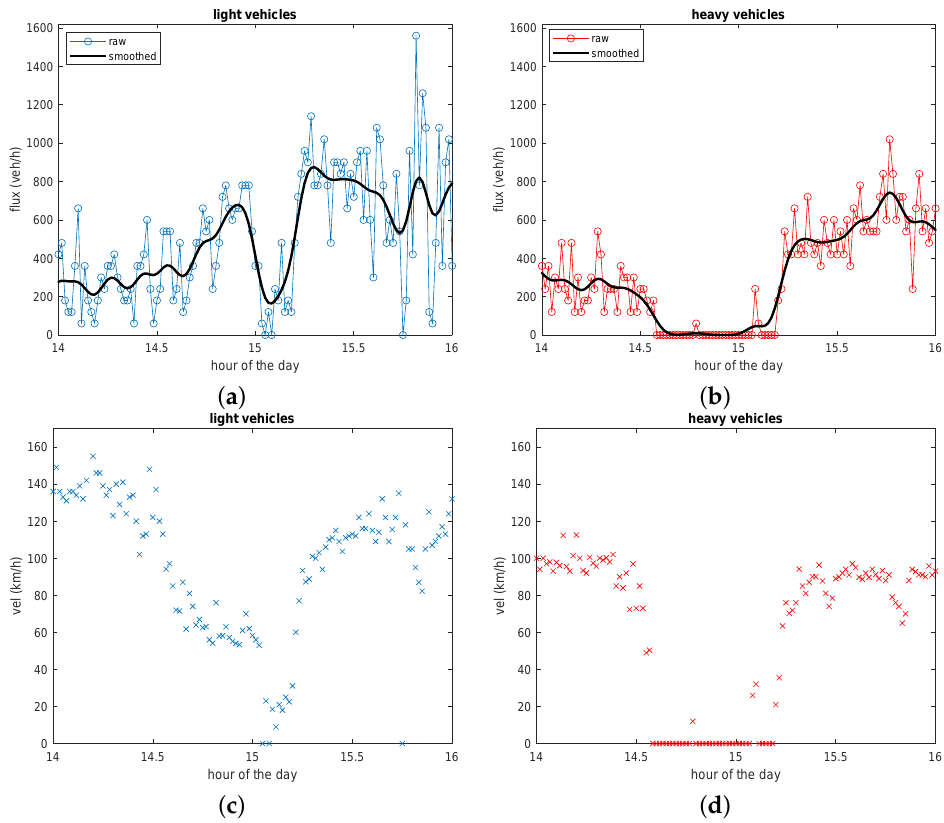
Figure 4. Creeping phenomenon registered in May 2019 near Portogruaro: ( a ) Light vehicles move in the fast lane even if ( b ) heavy vehicles queue in the slow lane. ( c ) Light vehicles’ velocity drops from 140 to 60 km/h and then to 20 km/h while ( d ) heavy vehicles are completely ∼ ∼ ∼